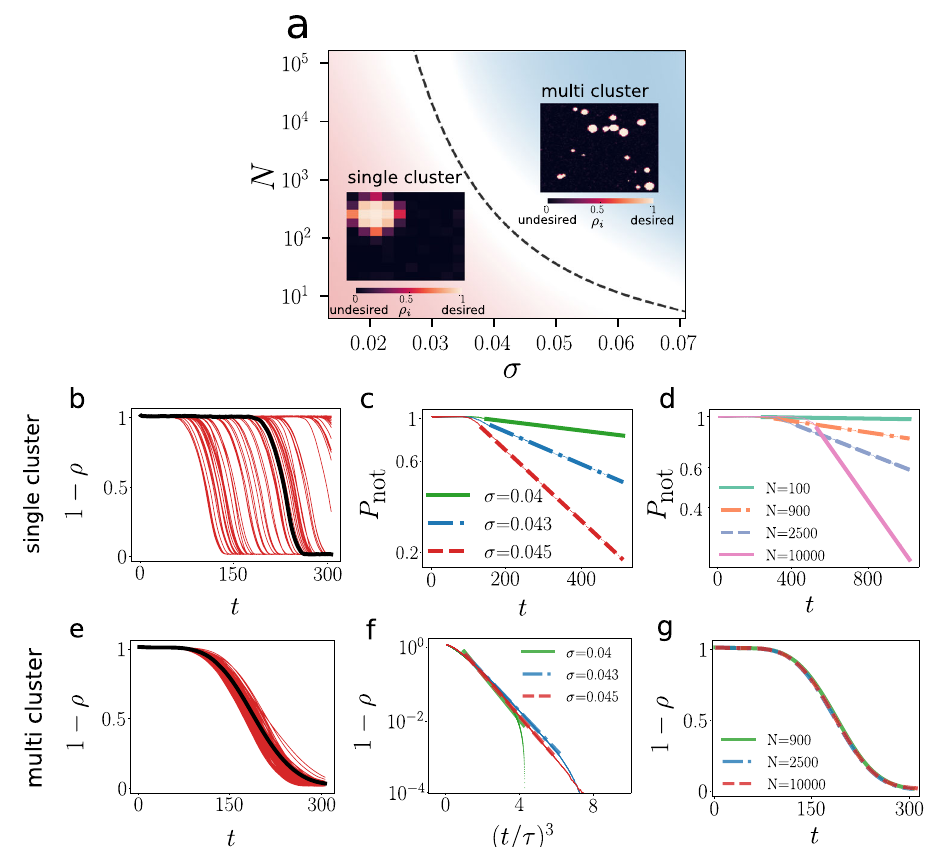
Fig. 6 Single-cluster and multi-cluster modes in the harvesting system. The parameters are set as r = 1 (de fi ned as the maximum growth rate), K = 10 (de fi ned as the carrying capacity), the diffusion rate R = 0.02, and the bifurcation parameter β = 1.8. Initially, all of the nodes are at the low stable state ρ L , and they are driven to the high stable state ρ H in the presence of noise. a Two insets describe the snapshots of individual normalized state values ρ i for the single-cluster and multi-cluster mode, respectively. They are separated by a crossover region centered around the curve N 1 = 2 ¼ e c 3 σ 2 , where c is a constant decided by the dynamics, and σ is the standard deviation of noise (noise strength). As in Fig. 4, the gradual change of the background color (red-white- blue) is to qualitatively illustrate the continuous nature of the crossover from the single-cluster mode to the multi-cluster mode. b – d are about the single- cluster mode. b 100 realizations of the global state evolution (state ρ changes with time t ) for the system size N = 100 and the noise strength σ = 0.045. c The distribution of waiting time P not for the fi xed system size N = 100 and the varied noise strengths σ = 0.04, 0.043, 0.045. d P not for the fi xed weak noise σ = 0.035 and different system sizes N = 100, 900, 2500, 10,000. e – g correspond to the multi-cluster mode. e 100 realizations of the global state evolution for the system size N = 10,000 and the noise strength σ = 0.045, which are more centered around a certain value instead of being random in b . f The evolution of ρ averaged over 100 realizations for different noise strengths σ = 0.04, 0.043, 0.045. g The evolution of the global state ρ averaged over 100 realizations for the fi xed strong noise σ = 0.045 and large system sizes N = 900, 2500,